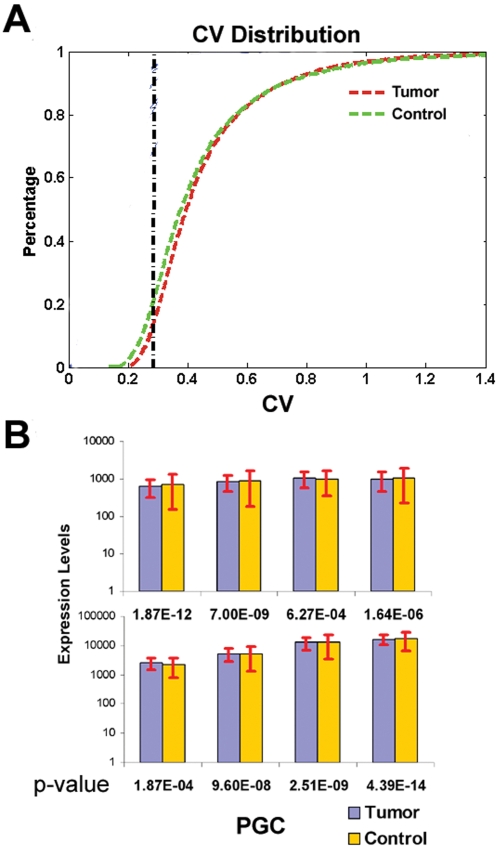
Gene expression variation in tumor and non-malignant samples.A) Distribution of gene expression variation (CV) in tissue samples. Equal numbers of tumor and control samples (50) were randomly selected from the training set to generate a cumulative distribution graph depicting the genome-wide distribution of CVs across tumors (red line) and controls (green line). Genes to the left of the distribution curve correspond to genes with decreased CV (stably expressed), while genes on the right are associated with increased CV. The threshold CVT of 0.28 (black dotted line) represents the CV value where ∼16% of genes in tumor samples are considered to be tightly regulated (i.e., CV<CVT, see Main Text for details). B) Expression variation of individual PGC genes in tumors and non-malignant samples. The height of the bar chart represents each gene's mean expression level (in log scale) across all tumor and normal samples in the training set. Error bars (red lines) represent 2 standard deviations of expression values. PGC genes show significantly restricted variation in tumors (blue bar) related to control (yellow bar). P-values calculated by F-test were provided for each PGC gene (x-axis). Note that the mean expression levels of the PGC genes are similar between tumors and controls.